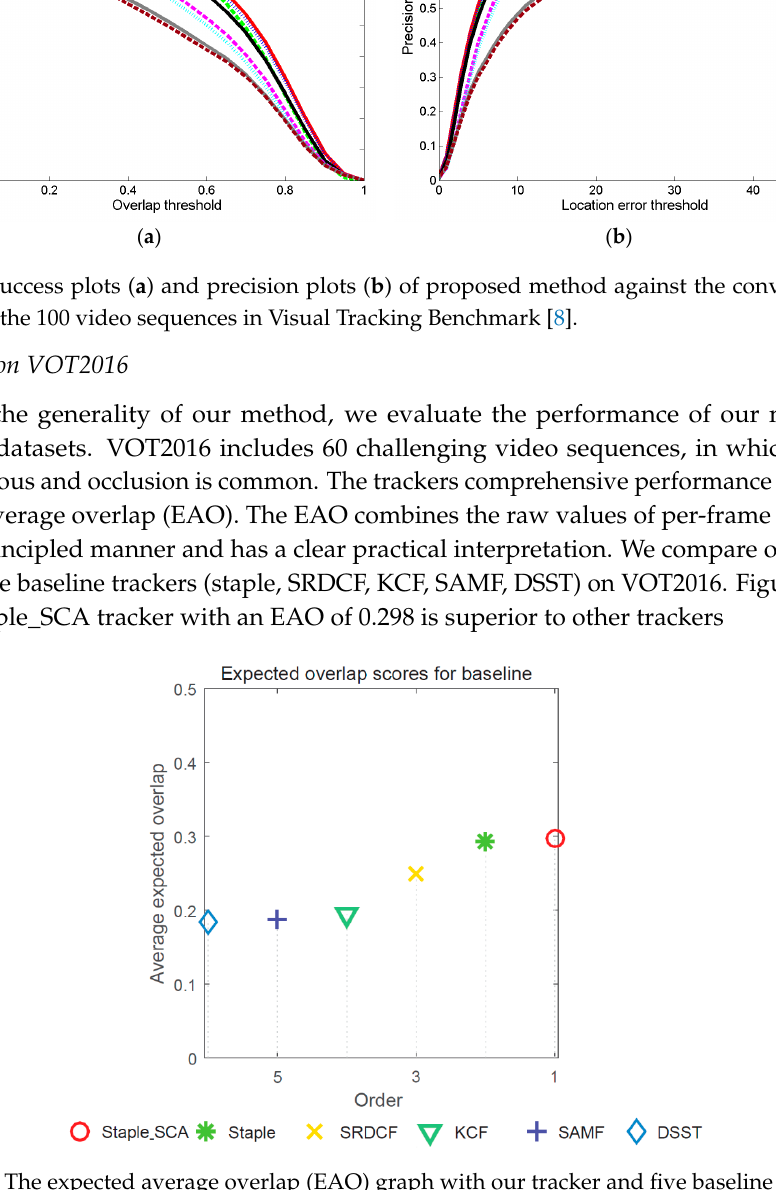
Figure 9. The expected average overlap (EAO) graph with our tracker and five baseline trackers.